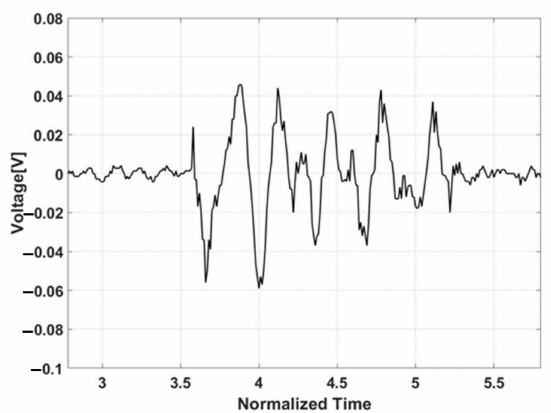
Figure 13. Difference between passive control and active